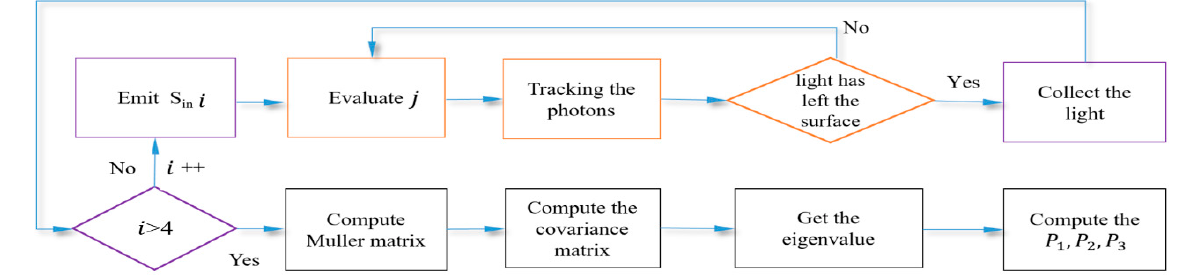
Figure 3. The flow chart of Monte Carlo.